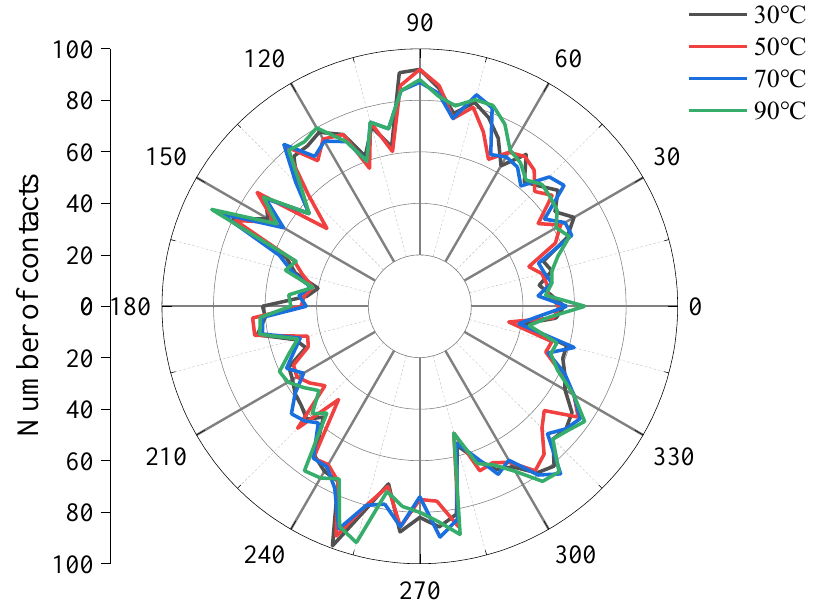
Figure 15. Contact configuration distribution after loading at different temperatures.